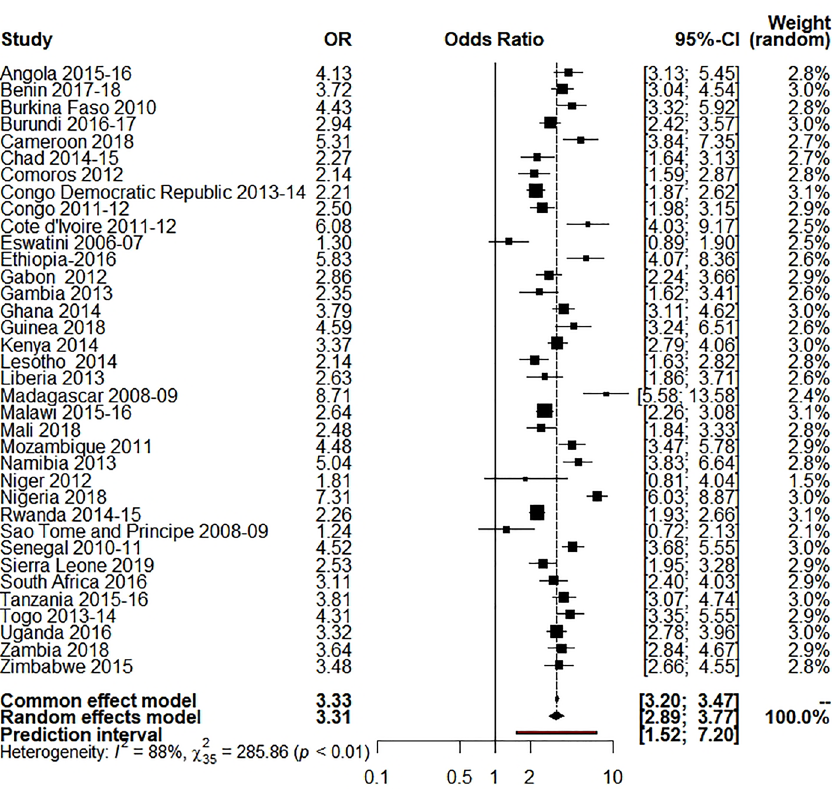
Figure 3. Forest plot for wealth